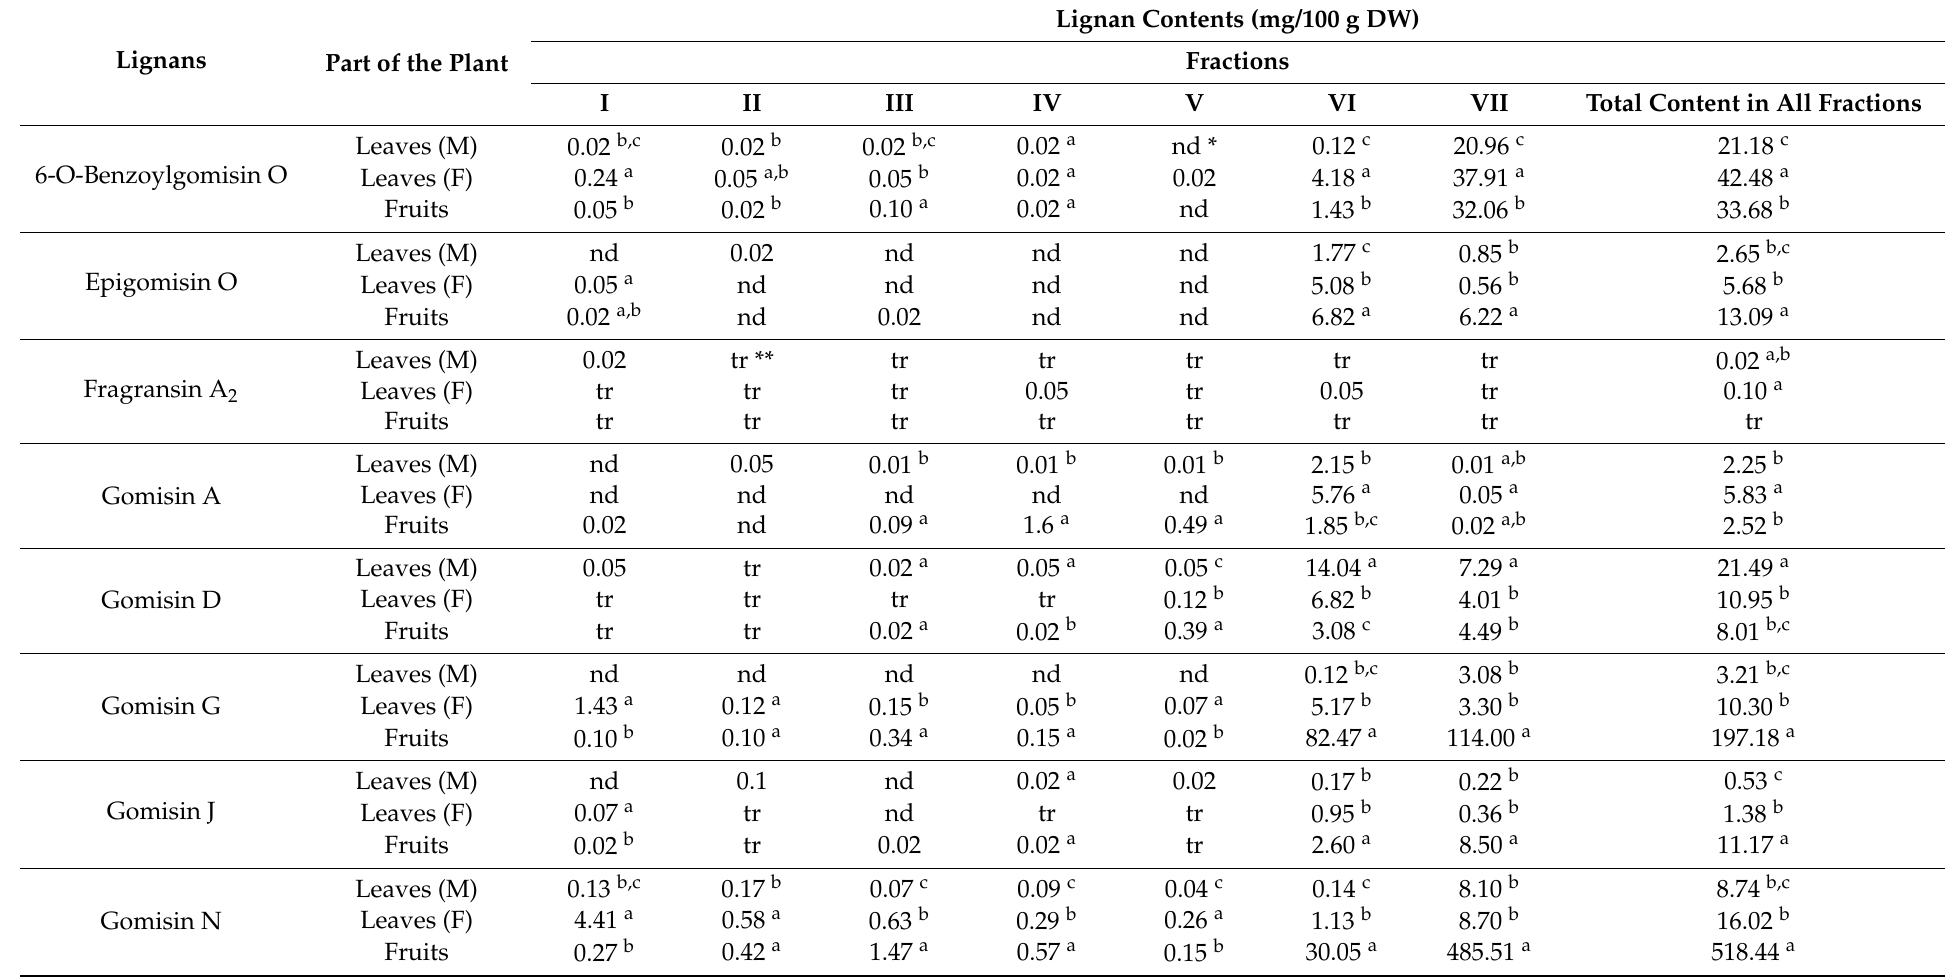
Table 1. The individual lignan contents in the fractions of fruits as well as male (M) and female (F) leaves of S. rubriflora